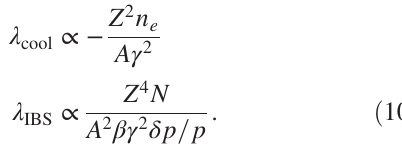
FIG. 7. Particle distribution in longitudinal phase space at equilibrium compared to the injected beam